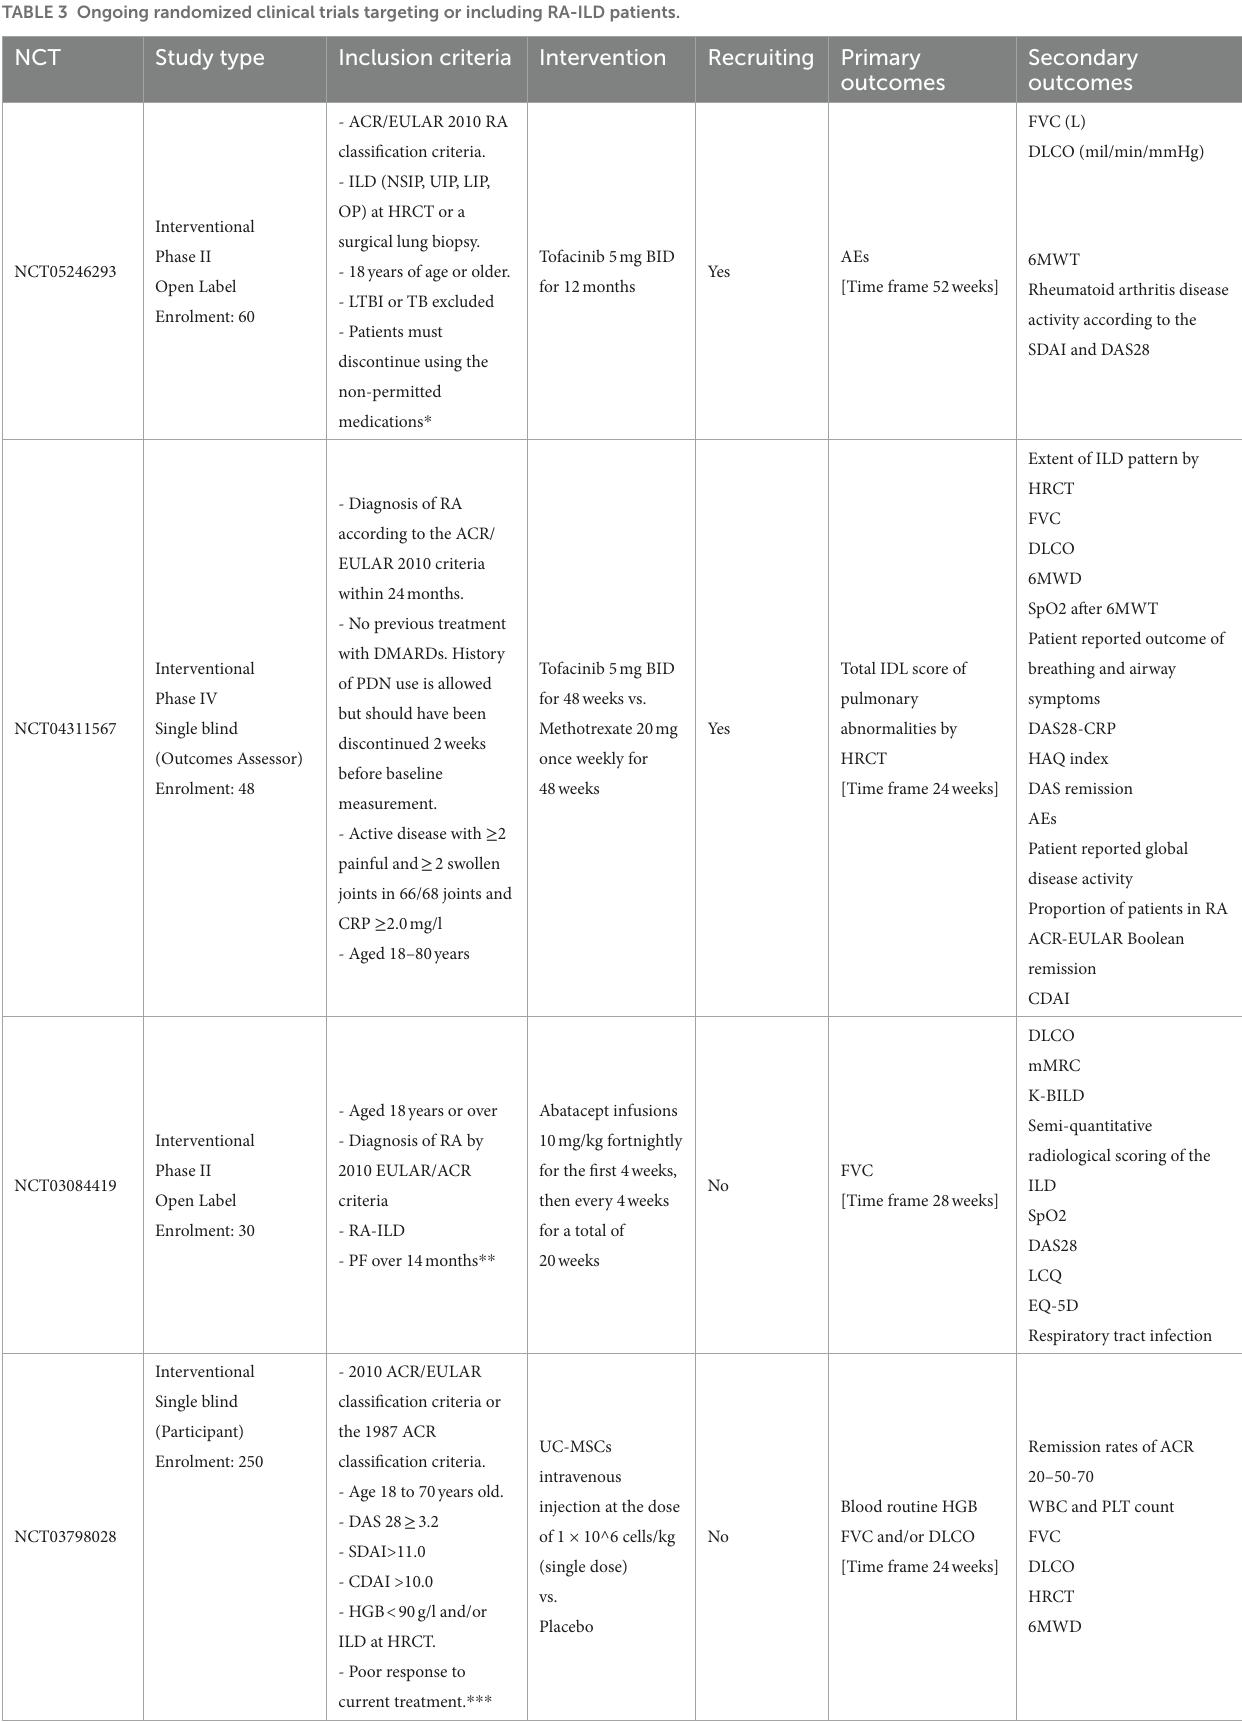
TABLE 3 Ongoing randomized clinical trials targeting or including RA-ILD patients. NCT Study type Inclusion criteria Intervention Recruiting Primary